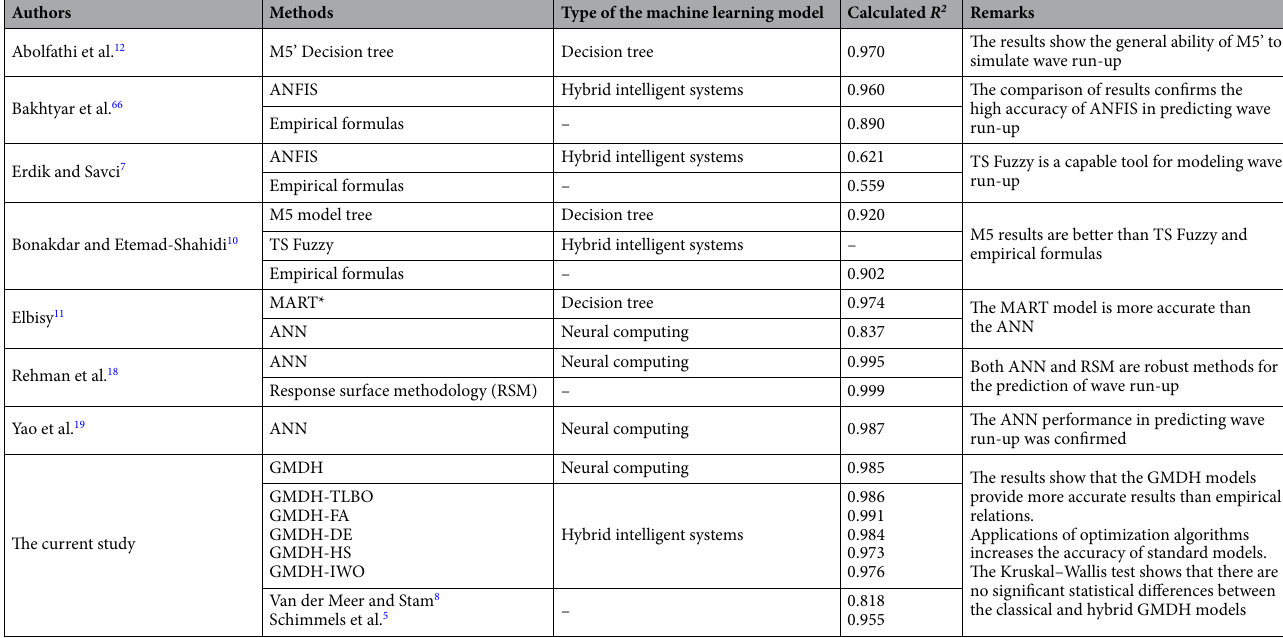
Table 8. Summary of the studies conducted to predict wave run-up in coastal regions. *Multiple additive regression